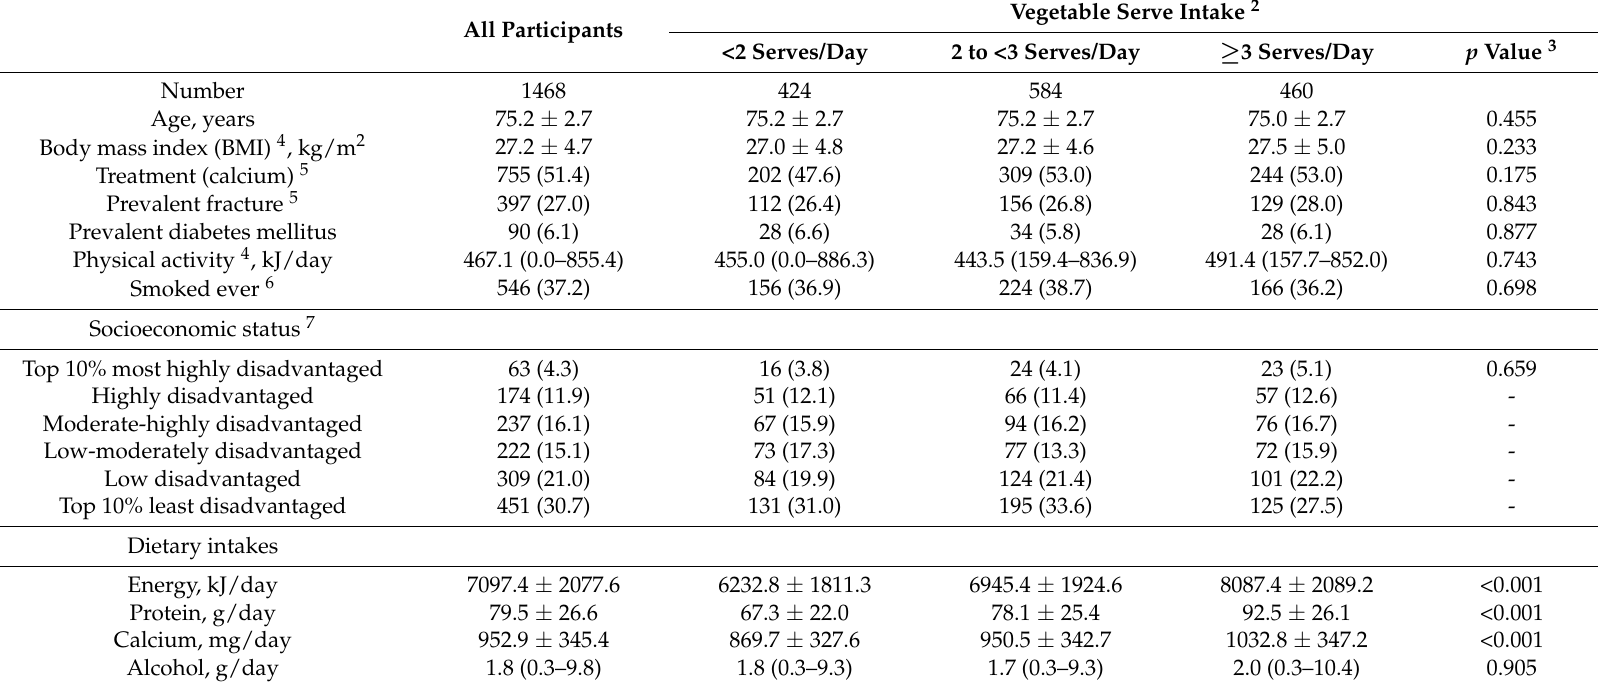
Table 1. Baseline characteristics according to all participants and vegetable intake categories 1